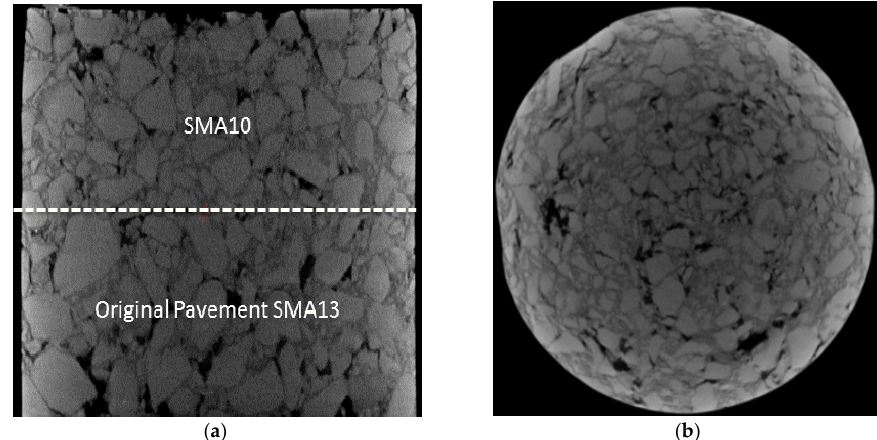
Figure 10. The scanning images for the cored sample from SMA10 pavement: ( a ) front view for cored sample; ( b ) the interface between wearing course with SMA10 and sub ‐ layer with SMA13.